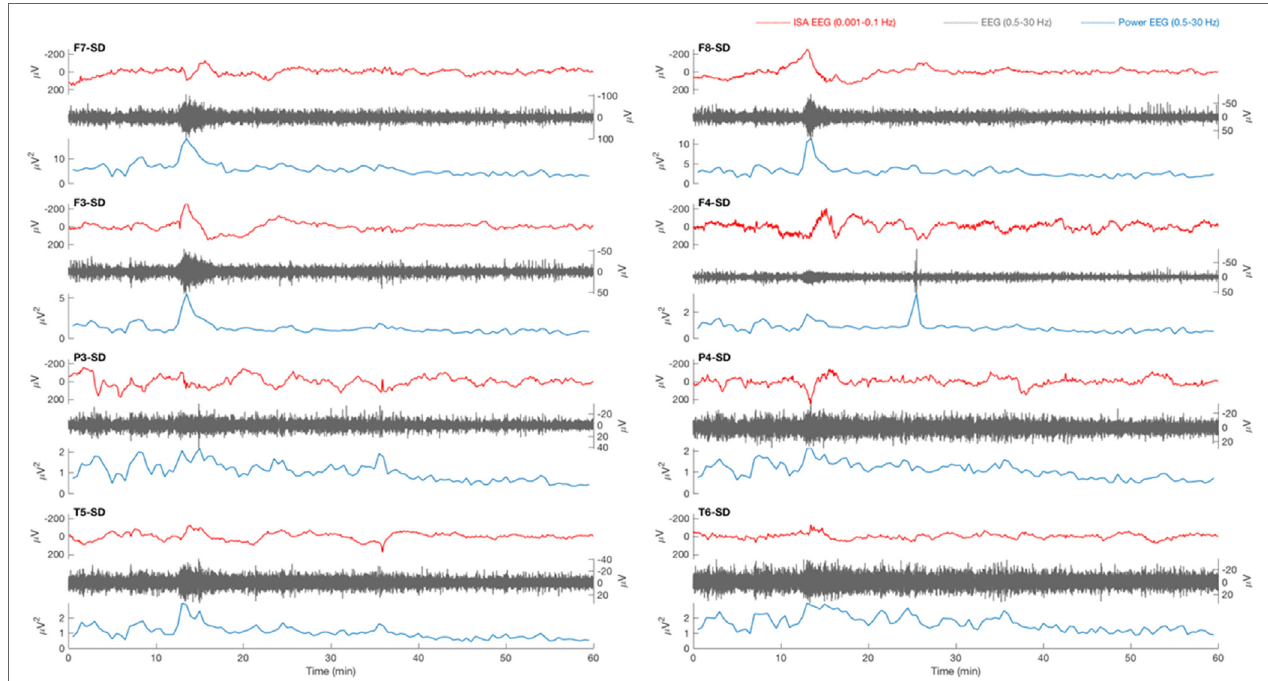
FigUre 1 | Typical example of a 1 h electroencephalography (EEG) overview from patient 18 with traumatic brain injury. Source derivation for four electrodes (F7, F3, P3, and T5) for the left hemisphere and four electrodes (F8, F4, P4, and T6) for the right hemisphere are displayed. The infraslow activity (ISA, 0.001–0.1 Hz, red) shows a slow potential change (SPC) at minute 13 on positions F7, F3, F8, F4, and P4. On other positions, the activity is less prominent. A simultaneous increase of the amplitude (gray) and power (blue) of faster EEG activity (0.5–30 Hz, gray) can be seen in all electrodes. The SPC is not focal, not accompanied by a depression of spontaneous activity, and there is no delay between appearances on the various electrodes, as expected in cortical spreading depolarization